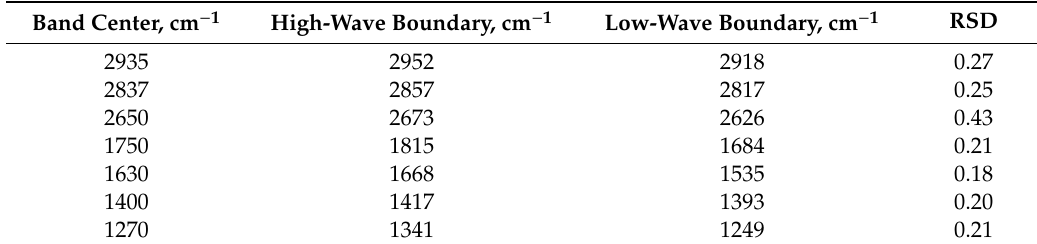
Relative standard deviation of band integral intensities in the wavenumber range 3000–2000 cm –1 by ATR–FTIR (RDDM ND brand).